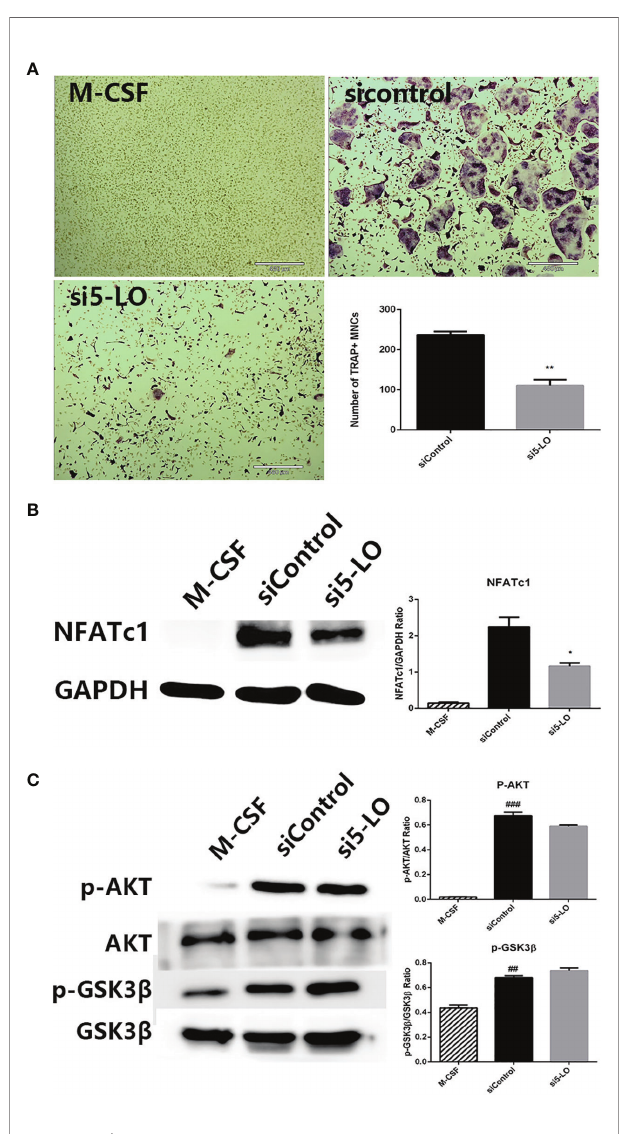
FIGURE 6 | The effects of 5-LO knockdown on RANKL-induced osteoclastogenesis. (A) TRAP staining of BMMs transfected with control siRNA or 5-LO targeted siRNA and cultured with M-CSF and RANKL for 4 d. 40× magni fi cation. Scale bars, 460 m m. (B) Western blotting of NFATc1 and GAPDH protein expression in cells treated as in (A) . Relative protein expression was quanti fi ed using ImageJ software (right panel). (C) Western blotting of AKT, and GSK3 b protein expression in cells treated as in (A) . Relative protein expression was quanti fi ed using ImageJ software (right panel). All experiments were performed in duplicate at least three times. ## p < 0.01 and ### p < 0.001 versus M-CSF group. * p < 0.05 and ** p < 0.01 versus siControl